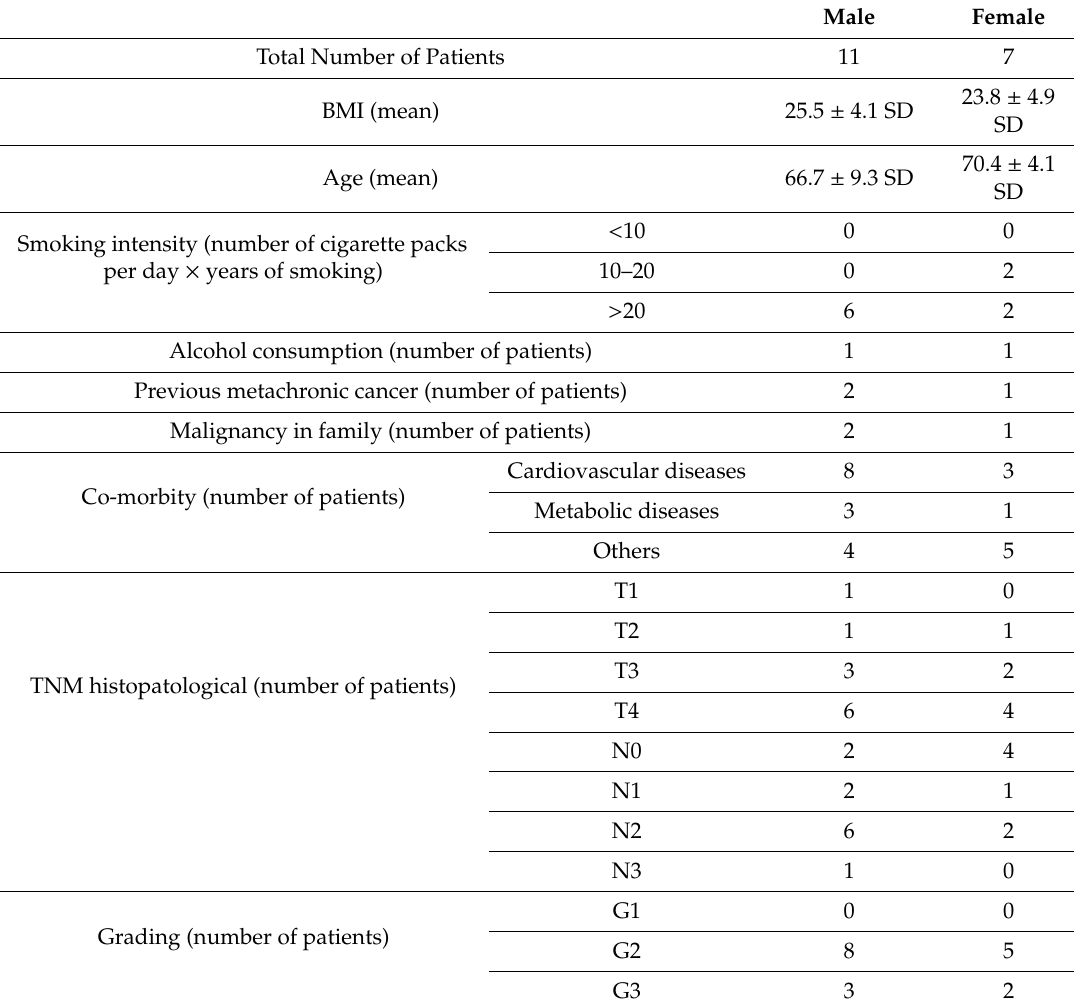
Table 1. Epidemiological